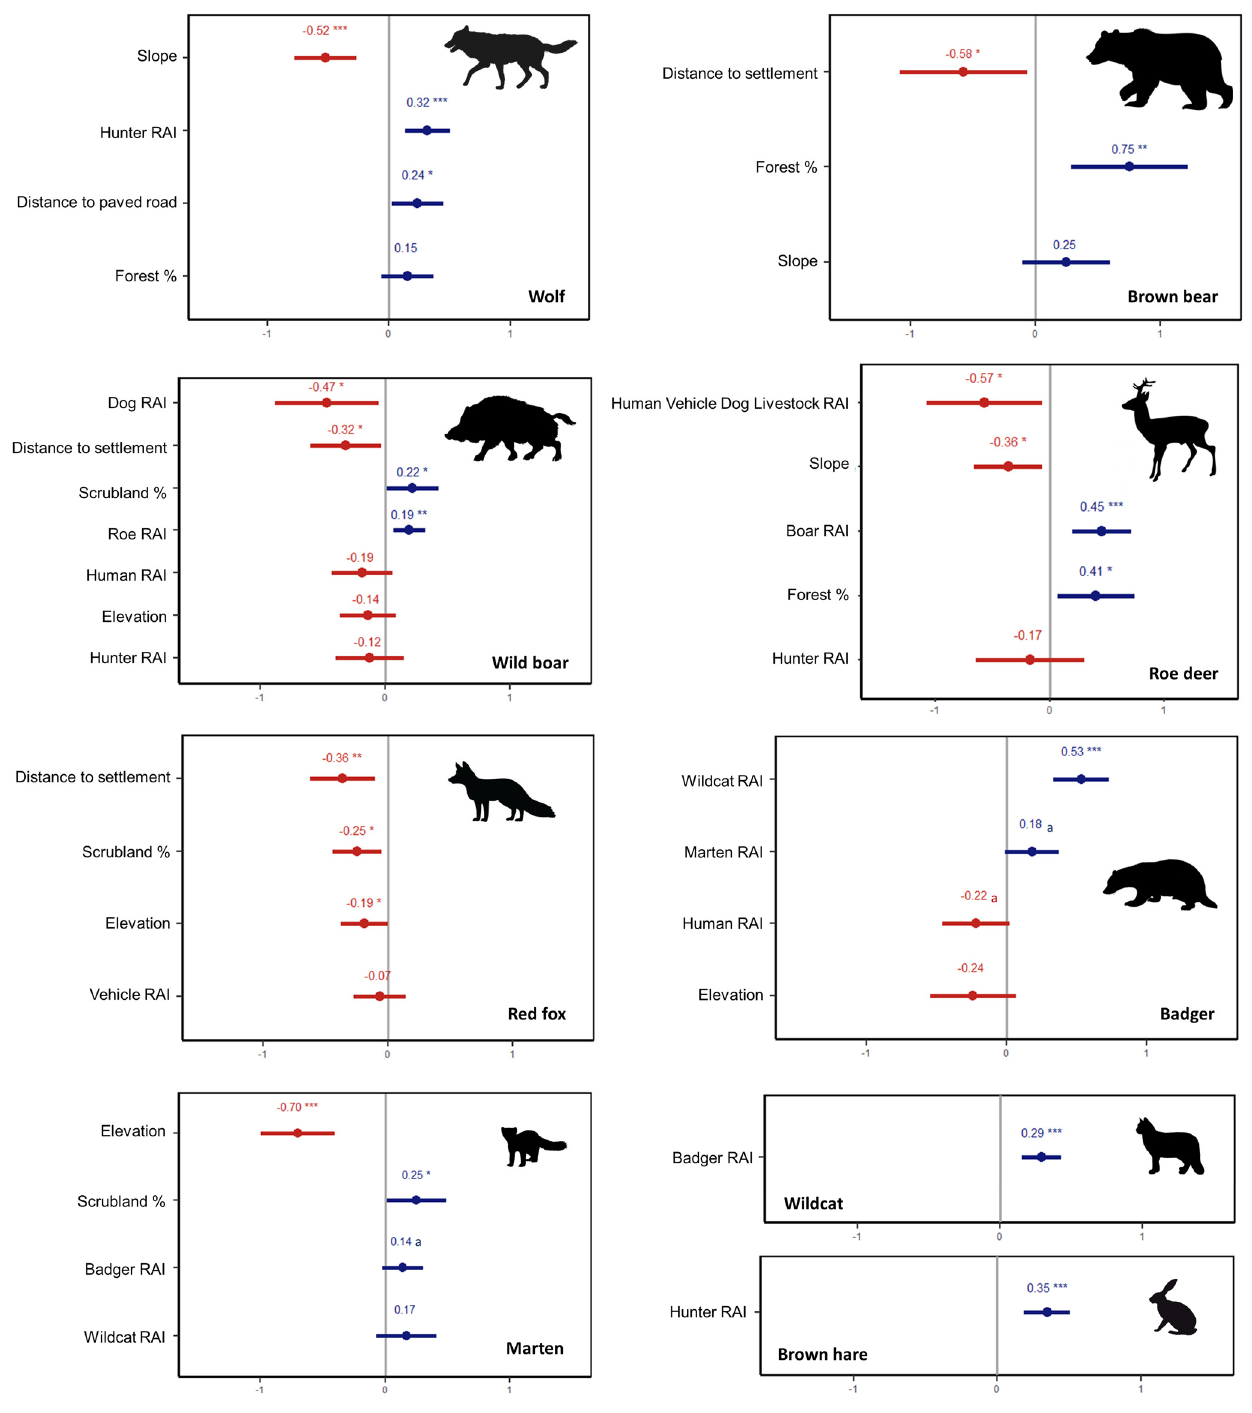
Figure 4. Model-averaged coefficients ( β ) with 95% confidence intervals (CI, bars) from predictor variables included in Generalized Linear Models used to investigate factors influencing detection rate of wild mammals in Greece, 2019–2020. Red color: negative effect ( β < 0). Blue color: positive effect ( β > 0). Asterisks show the significance levels corresponding to whether the 95% CI overlaps zero, which indicates no significant effect. a Marginally significant effect at the 90% CI level.